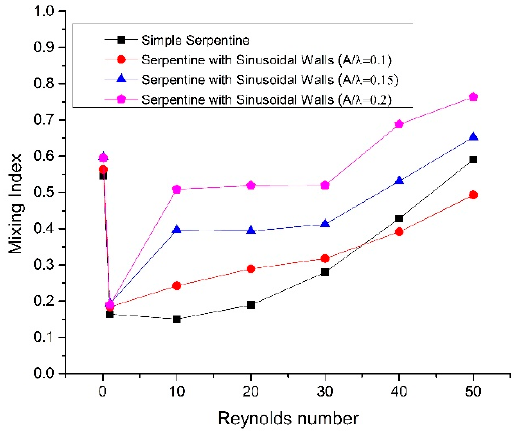
Figure 7. Mixing Index at stream wise length of 6.2 mm.